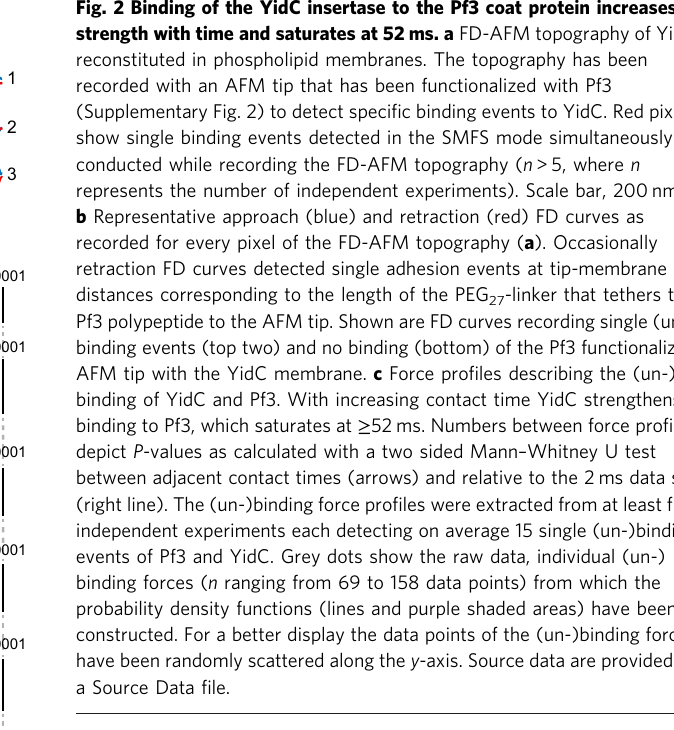
Fig. 2 Binding of the YidC insertase to the Pf3 coat protein increases strength with time and saturates at 52 ms. a FD-AFM topography of YidC reconstituted in phospholipid membranes. The topography has been recorded with an AFM tip that has been functionalized with Pf3 (Supplementary Fig. 2) to detect speci fi c binding events to YidC. Red pixels show single binding events detected in the SMFS mode simultaneously conducted while recording the FD-AFM topography ( n > 5, where n represents the number of independent experiments). Scale bar, 200 nm. b Representative approach (blue) and retraction (red) FD curves as